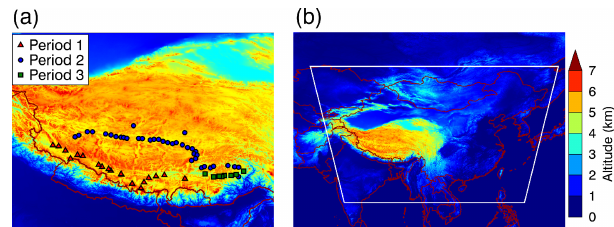
Figure 1. Overview of regions involved in this study. Locations of observations for period 1 (13–17 October 2010, triangle), pe- riod 2 (19–24 October 2010, circle), and period 3 (25 October 2010, square) are shown in (a) . White polygon in (b) represents the model domain margin of REAM. Altitude data from Global Topographic Data (GTOPO30, courtesy of the US Geological Survey) are shown as colored